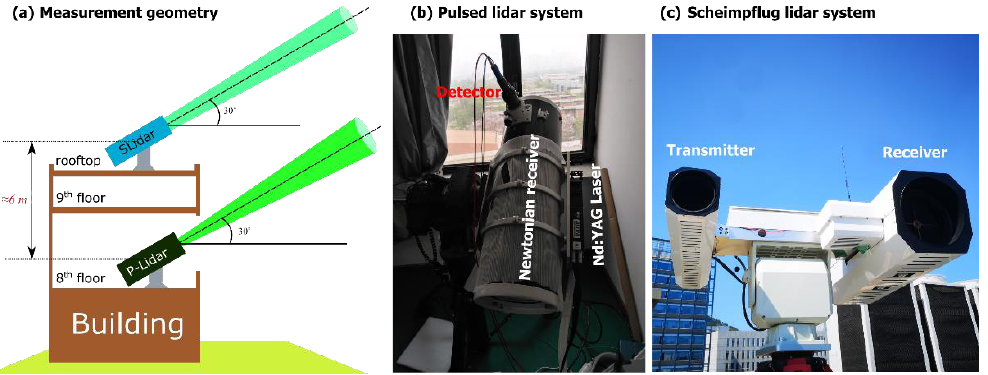
Figure 1. (a) Measurement geometry, (b) the picture of the pulsed lidar system, and ( c ) the picture of the Scheimpflug lidar system. The water-proofed SLidar system was placed on the rooftop of the building, while the pulsed lidar system was located inside a